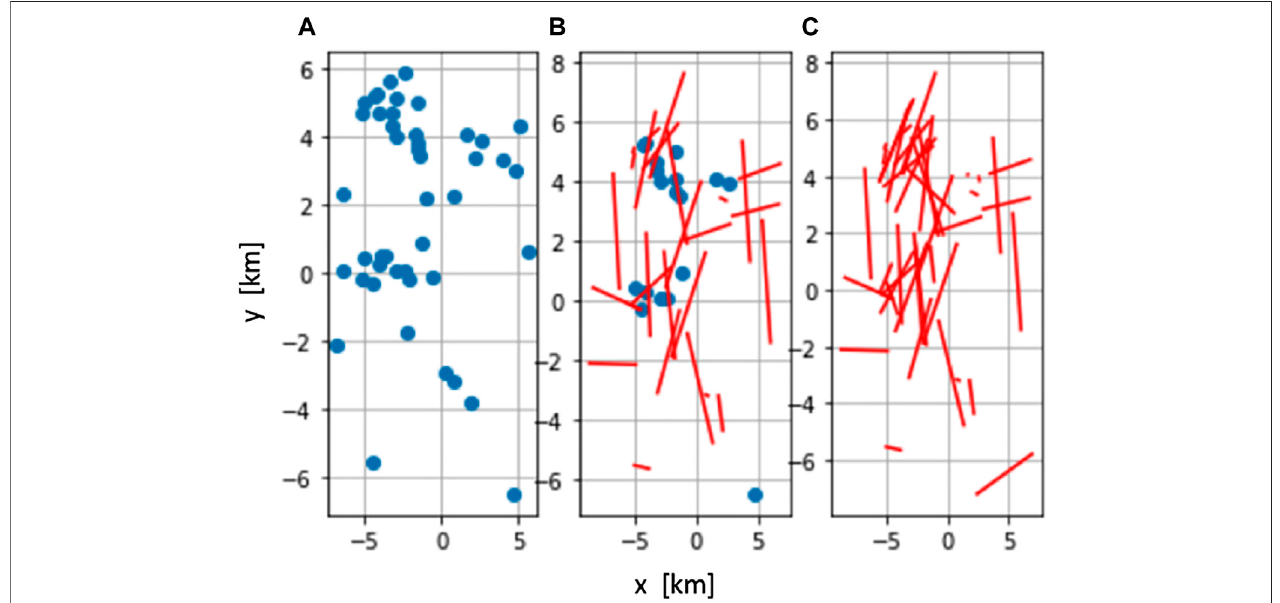
FIGURE 4 | CML network in Gothenburg (Andersson et al., 2017) — (C) ; two simulated networks where all CMLs are replaced by RGs (A) or 40% of CMLs are randomly replaced by RGs (B) .